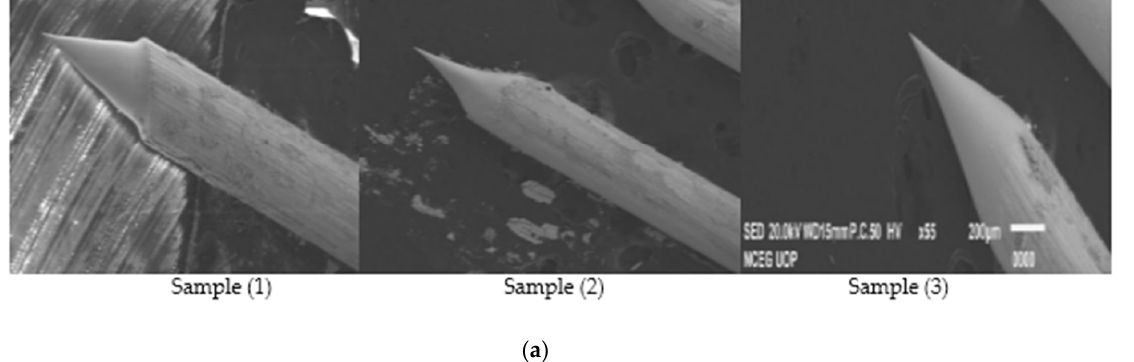
Figure 8. ( a ) SEM Images showing Sample 1 having applied voltage of 6.6 V in 2 M NaOH solution; ( b ) Zoomed-in-View of Sample 1, 2 and 3; ( c ) SEM Images of 0.4 mm tungsten tips showing cone angle and tip diameter measured using AutoCAD Software.